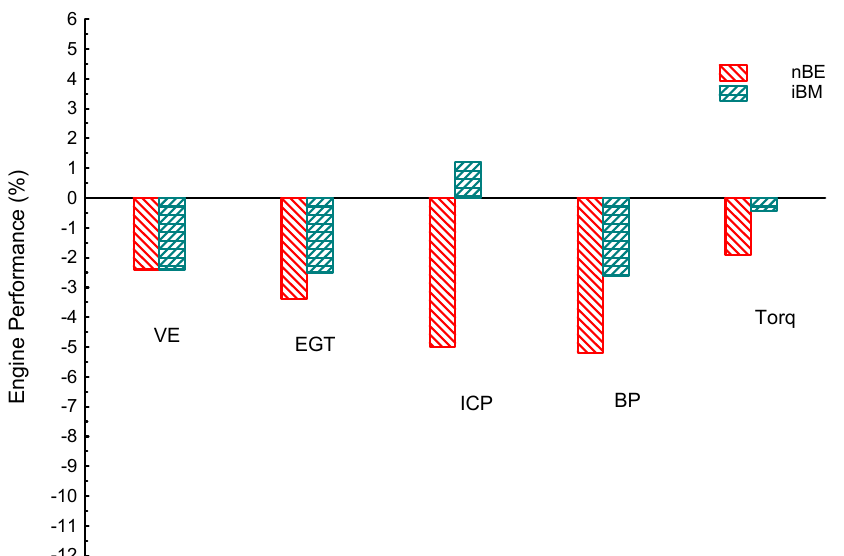
Figure 5. Comparison of volumetric efficiency (VE), exhaust gas temperature (EGT), in-cylinder pressure (ICP), brake power (BP), and torque (Torq) for i-butanol–bio-methanol–gasoline blends (iBM), n-butanol–bio-ethanol–gasoline blends (nBE) and neat gasoline (baseline) on average basis.